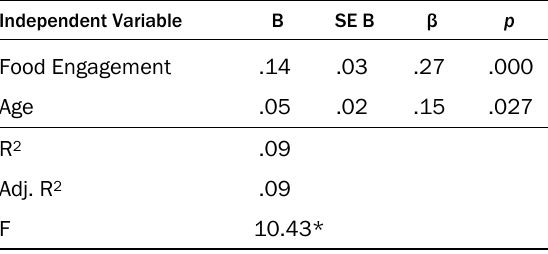
Table 10. Dependent Variable: Behavioral Aesthetics